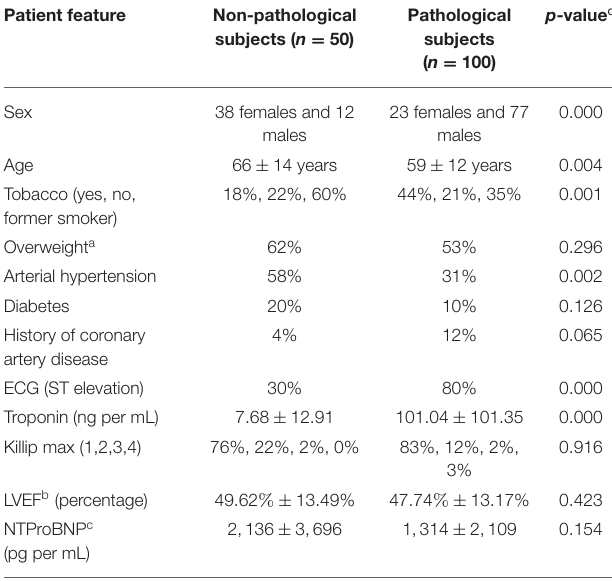
TABLE 1 | Characteristics of pathological and non-pathological patients [according to the Delayed Enhancement MRI (DE-MRI)]. Patient feature